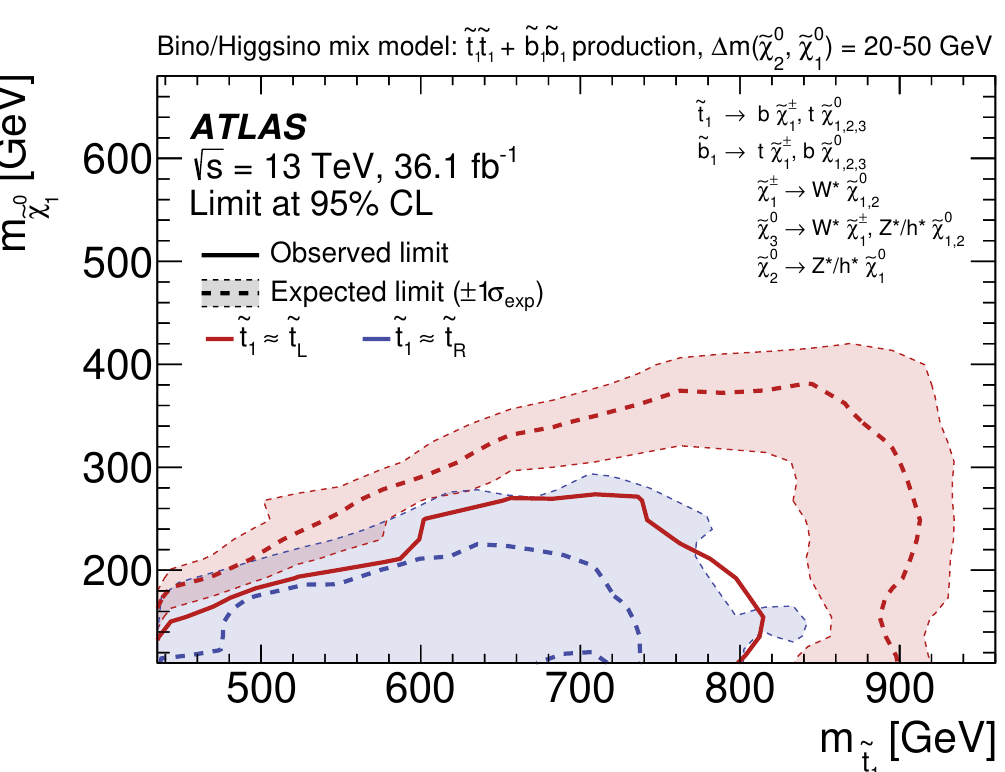
Figure 27 . Expected (dashed) and observed (solid) 95% excluded regions in the plane of m versus ~ (cid:31) 0 1 m ~ for direct stop/sbottom pair production in the well-tempered neutralino model where various t 1 (cid:6) (cid:6) ~ b ~ t decay modes (~ t b ~ (cid:31) t ~ (cid:31) 0 1 , ~ t t ~ (cid:31) 0 2 , ~ b t ~ (cid:31) b ~ (cid:31) 0 1 , and ~ b b ~ (cid:31) 0 2 ) are considered 1 , 1 , 1 ! 1 ! 1 ! 1 ! 1 ! 1 ! with di(cid:11)erent branching ratios for each signal point. Contours for the m q 3 L <m tR and m q 3 L >m tR hypotheses are shown separately as red and blue lines, respectively. For the m q 3 L <m tR hypothesis, both stop and sbottom pair production is considered while for the m q 3 L >m tR hypothesis, only stop pair production is